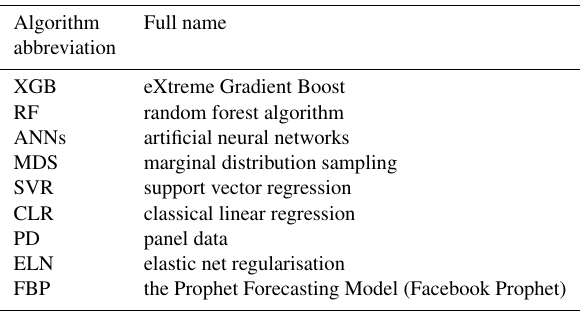
Table 4. The name and the abbreviation of the gap-filling algo-